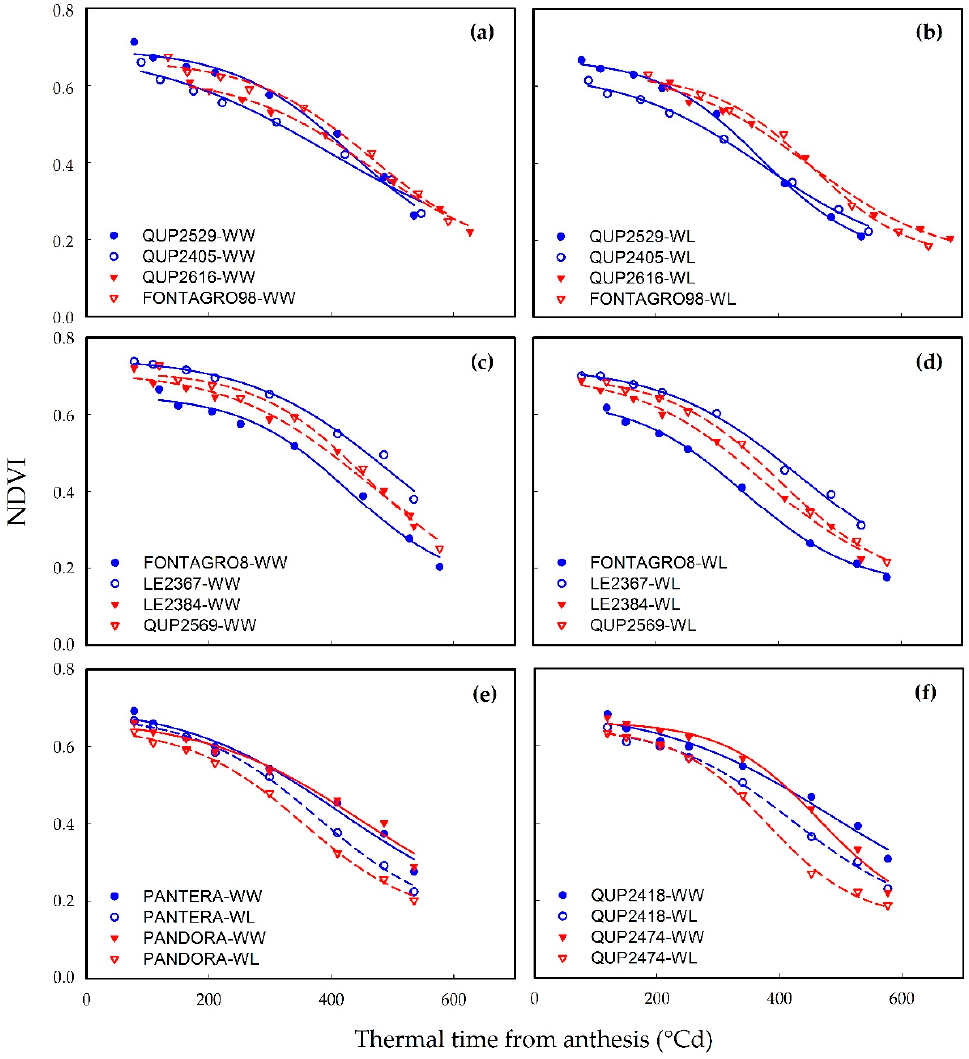
Figure 3. Dynamic of canopy senescence in a set of contrasting spring bread wheat genotypes from field experiment. ( a – d ) Panels highlight the variation among lines grown under ( a – c ) well-watered (WW) and ( b – d ) water-limited (WL) conditions. ( e , f ) Panels highlight the variation between water regimes. In ( a – f ), each point represents the average of four replicates but the curves were fitted using individual replicates. Symbols represent measured experimental normalized difference vegetative index (NDVI) values, whereas the lines represent the regression curves fitted with the Equation (2).